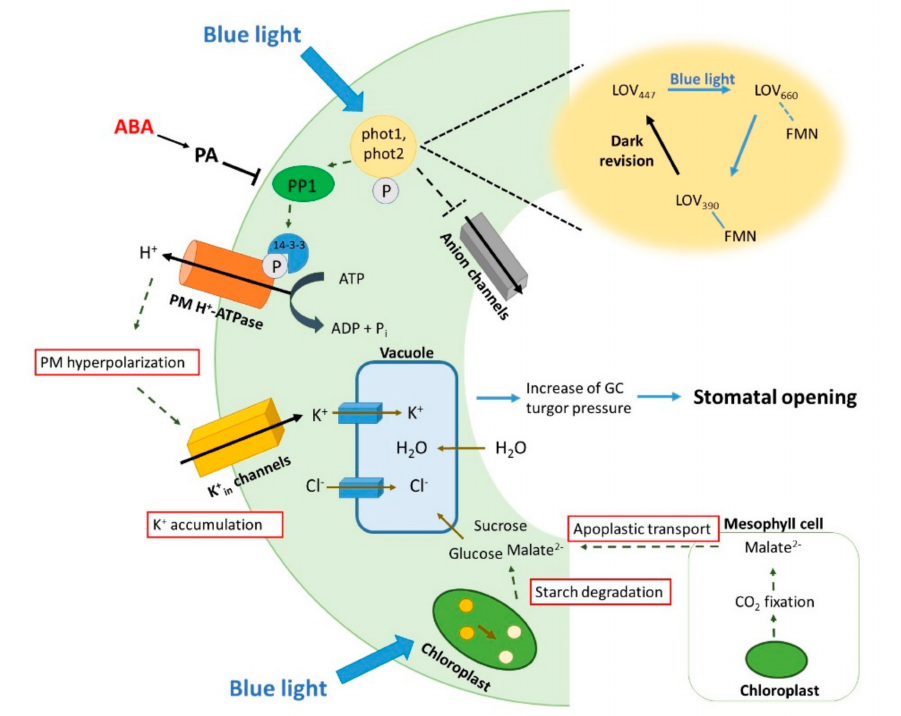
Figure 3. Blue light signaling pathway in stomatal guard cells. Blue light is perceived by phot1 and phot2, activating plasma membrane (PM) H + -ATPase, inducing K + uptake through K +